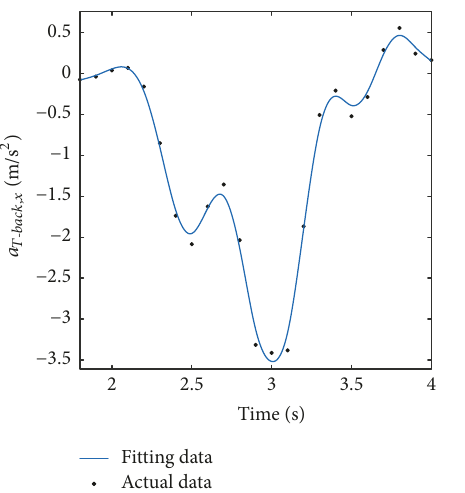
Figure 20: Acceleration curve of T-back in the positive direction of X-axis with time.